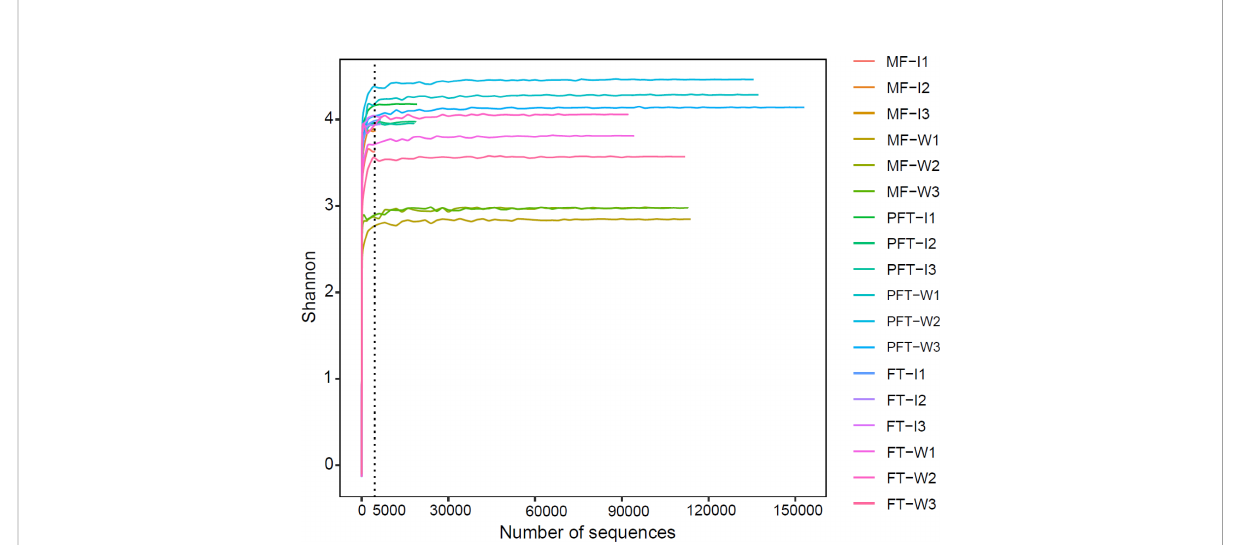
FIGURE 4 Shannon Wiener curves of the sample bacterial community of S. pharaonis from the mysid feeding period (MF), feed transition period (FT), and the post-feed transition period (PFT). W and I were surrounding water and intestinal samples, respectively. Operational taxonomic units (OTUs) were clustered based on 97% sequence similarity. The number of reads sampled indicates the number of sequencing reads.